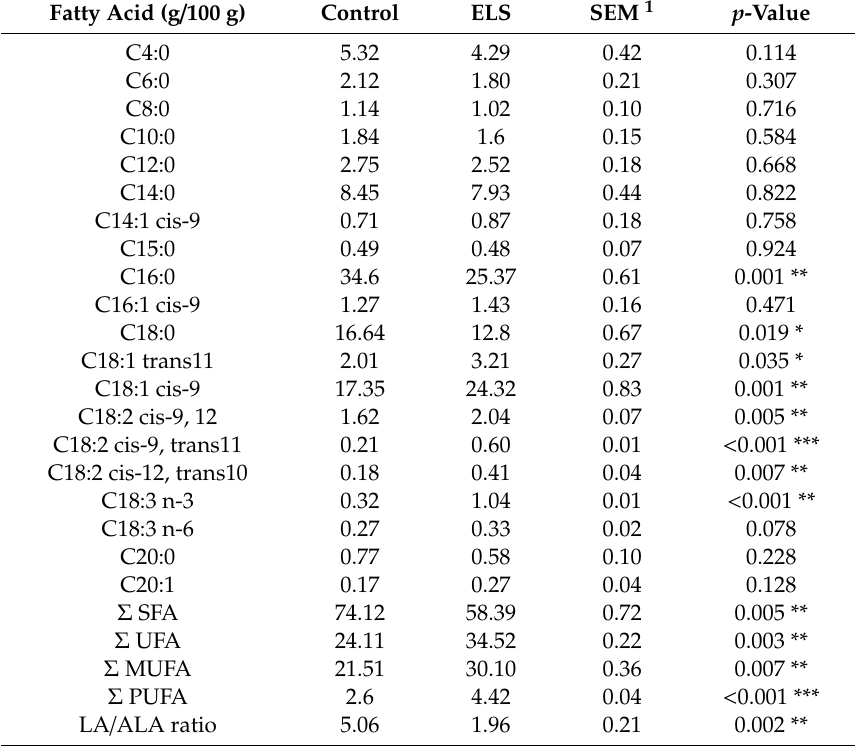
Table 5. Milk fatty acid composition and mean concentrations in control and supplemented (ELS) diets given to Holstein dairy cows.